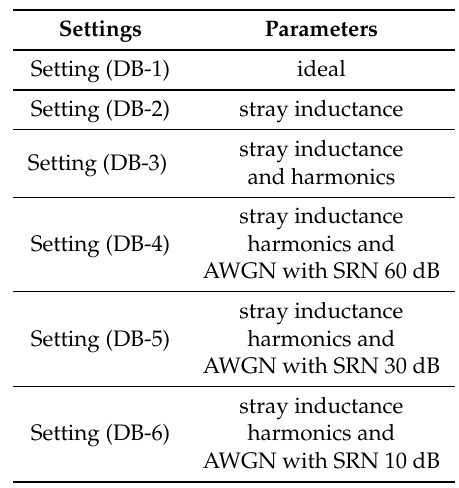
Table 9. Simulated subset